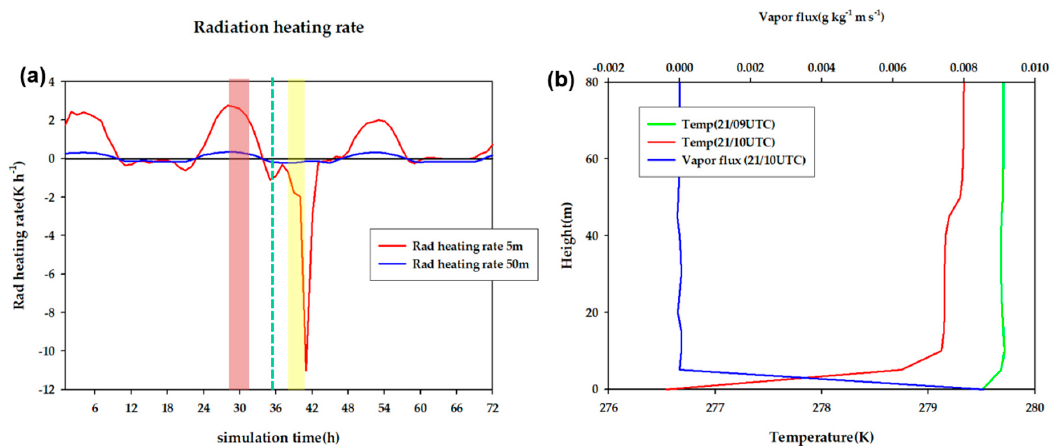
Figure 6. ( a ) Time variation of radiative heating rates at 5 m and 50 m and ( b ) vertical profiles of temperature and vapor flux at relevant times for the fog case depicted in Figure 4. Precipitation period is marked with red vertical bar and observed fog period is shaded yellow. The vertical dash green line refers to 10 UTC.